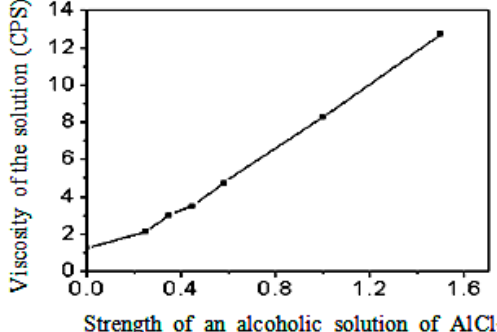
Figure 4. The viscosity of an alcoholic solution of a mixture of 0.01 M ErCl 3 6H 2 O and variable strength of AlCl 3 6H 2 O.